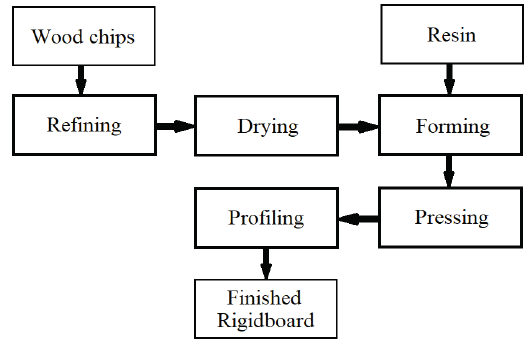
Fig. 3. Simplified rigidboard manufacturing process